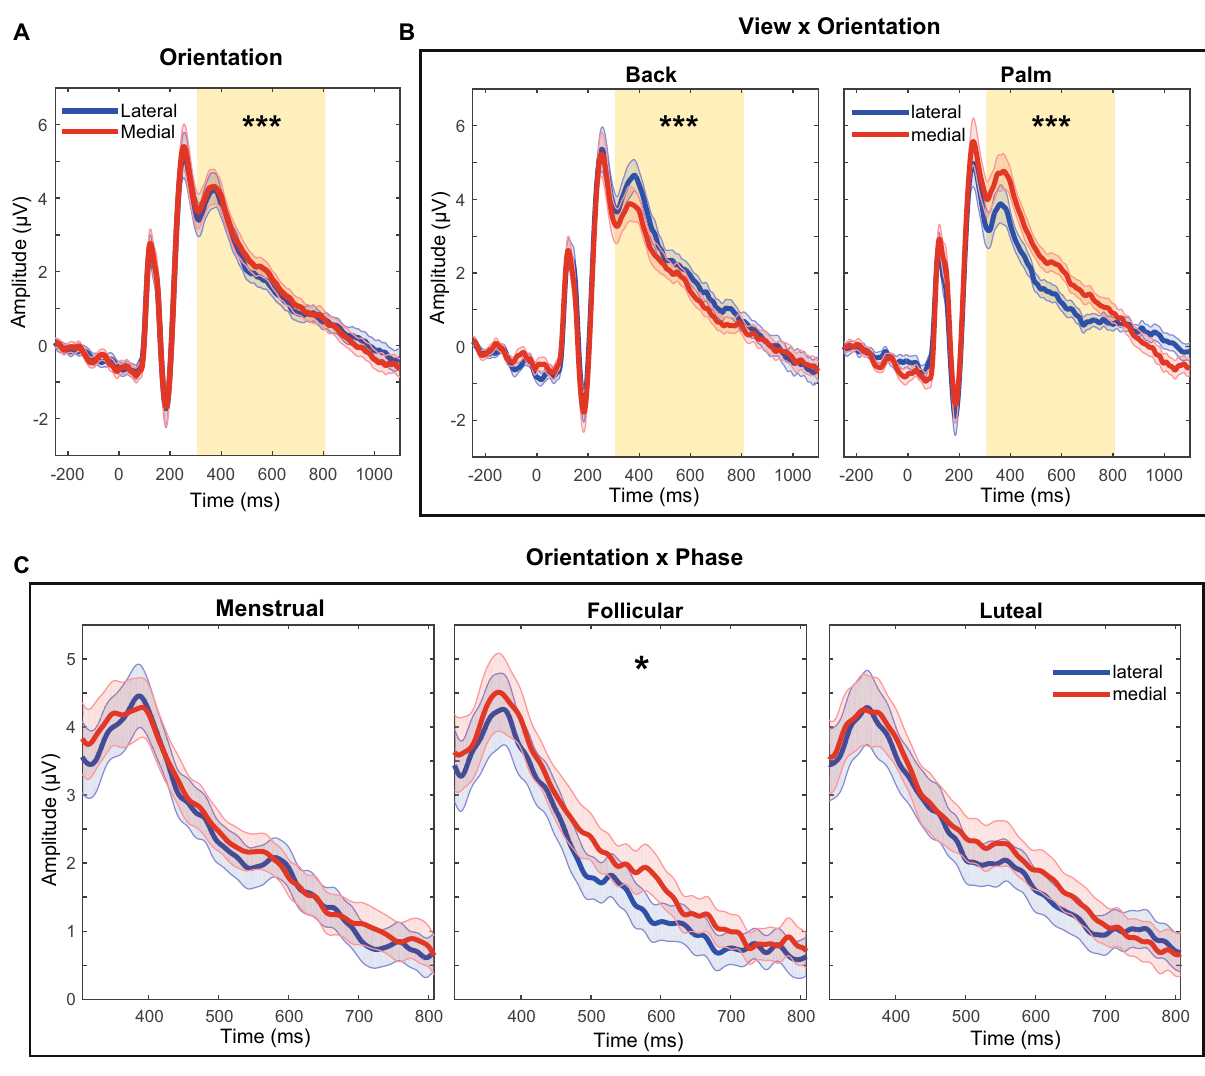
Figure 8. Effect of the menstrual cycle and hand features on ERP RRN in the left parieto-occipital region. ( A ) Main effect of orientation in ERP with higher RRN for lateral orientation than medial orientation. ( B ) View x orientation interaction effect on RRN. The RRN was higher for the lateral orientation then for the medial orientation for the palm view, the opposite was observed for the back view. The selected RRN window is highlighted by the yellow patch in the time interval between 305 and 808 ms after stimulus presentation (0 ms). ( C ) Orientation x phase interaction effect in the RRN window. The significant difference between the lateral and medial orientations was only observed for the follicular phase with a higher RRN for the lateral orientation than for medial orientation. RRN is represented in the time interval between 305 and 808 ms. P -value: < 0.001 (***), < 0.01 (**); < 0.05 (*); Bonferroni correction for post-hoc